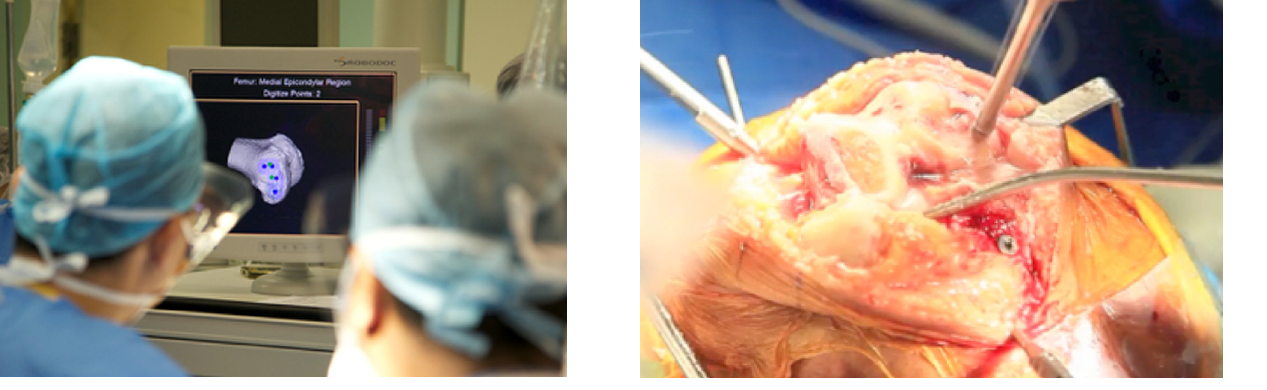
Figure 6. TCAT (cid:2) miller working on femur.